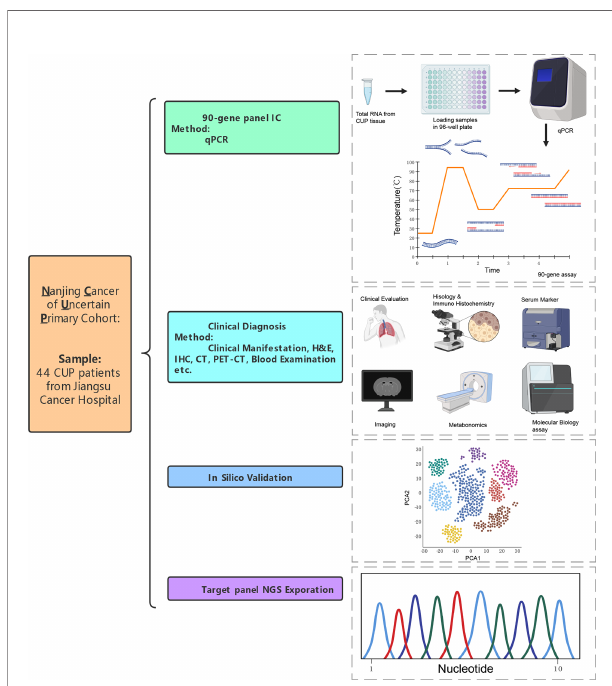
FIGURE 1 | An overview of research design that veri fi cation of 90-gene expression signature to identify the origin of CUP. TABLE 1 | Patients and clinical characteristics.